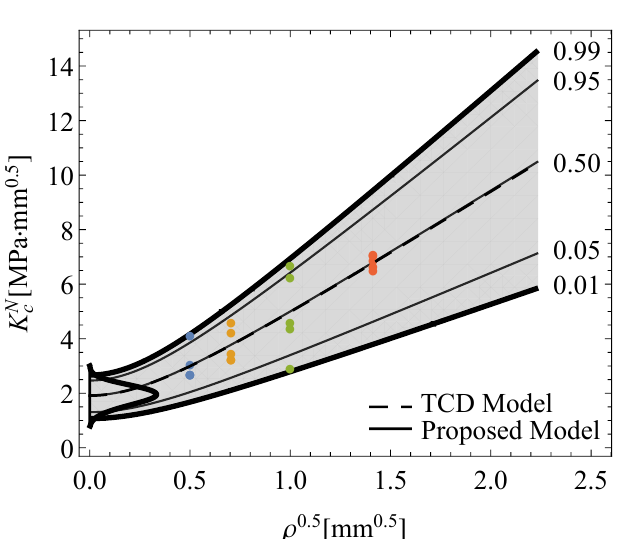
Figure 8. Theoretical predictions of the probabilistic K N c − ρ 0.5 field and the experimental values for the apparent fracture toughness of EPOLAM 2025.